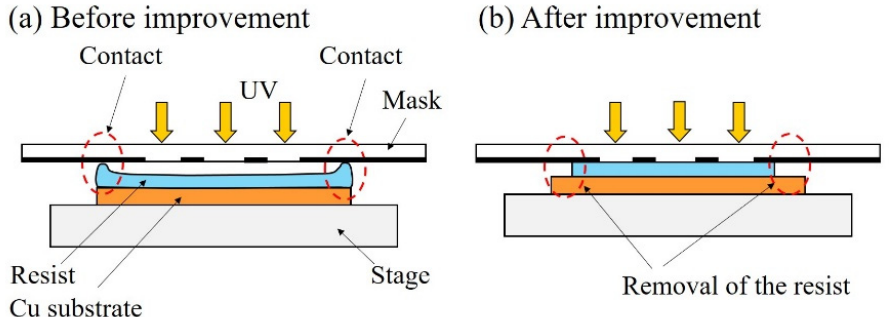
Figure 8. Improvement of the photolithography process. ( a ) After resist coating, the resist at the edge of the substrate is thick at approximately 60 µ m. ( b ) Resist at the edges is physically removed after improvement. The thickness of the resist is uniform at 30 µ m. There is no gap between the mask and substrate in the contact exposure.